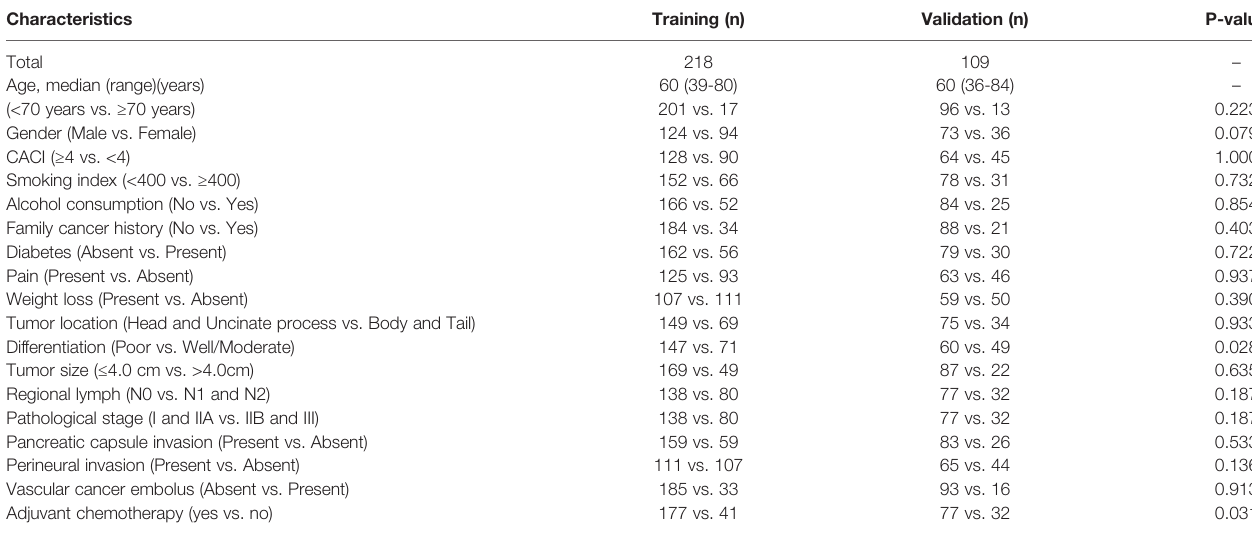
TABLE 1 | Clinicopathological characteristics of patients in the training and validation groups.